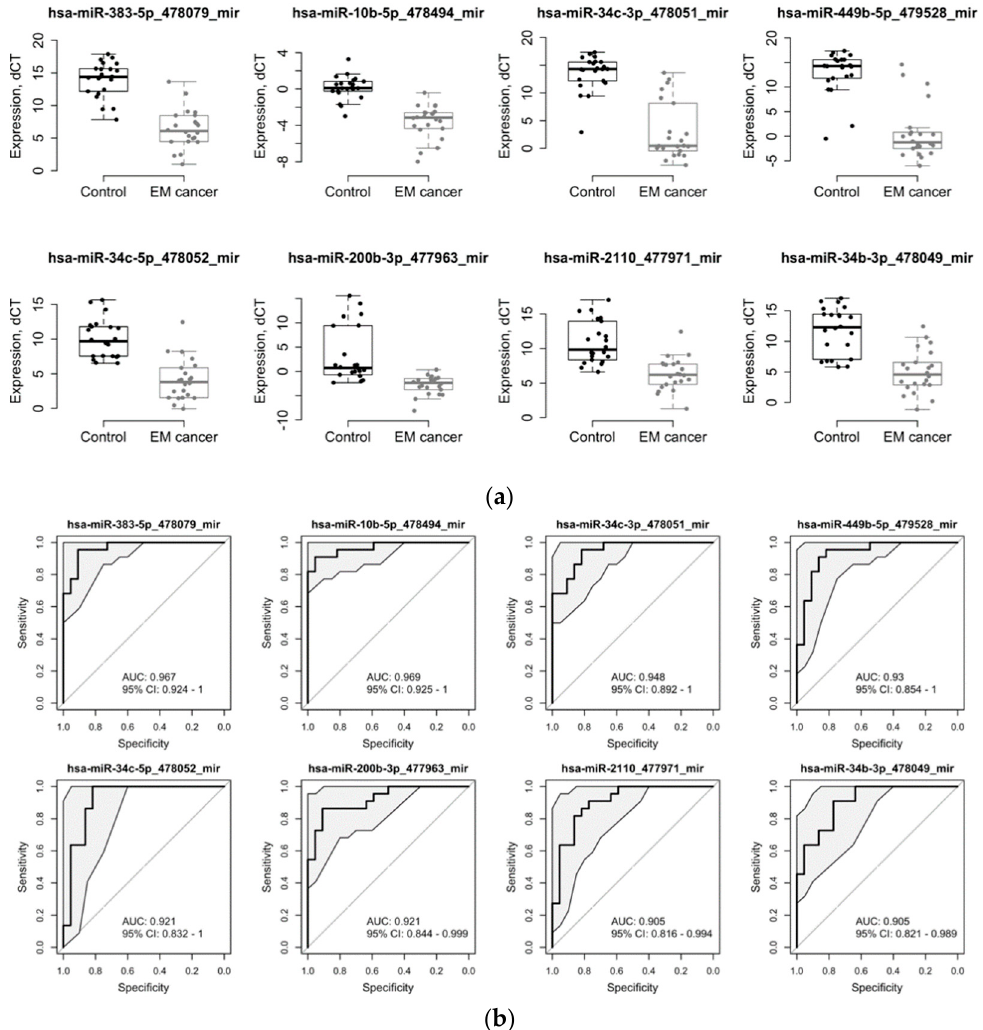
Figure 2. Diagnostic performance of the top eight differentially expressed miRNAs: ( a ) Relative dCT values of the top differentially expressed miRNAs in patients with EC ( n = 22) compared to control patients ( n = 22), ** p < 0.05; ( b ) receiver operating characteristic (ROC) curves and AUC scores for the top eight differentially expressed miRNAs.